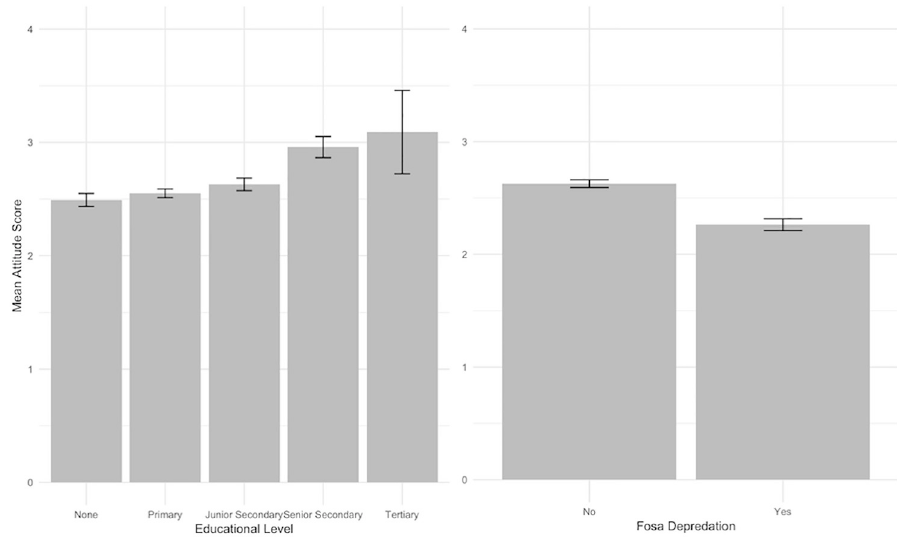
Fig 4. The significant predictors of interviewees’ stated attitude towards fosas (y-axis scale likert-scale from 1 strongly dislike to 5 strongly like), including the standard error of the mean.